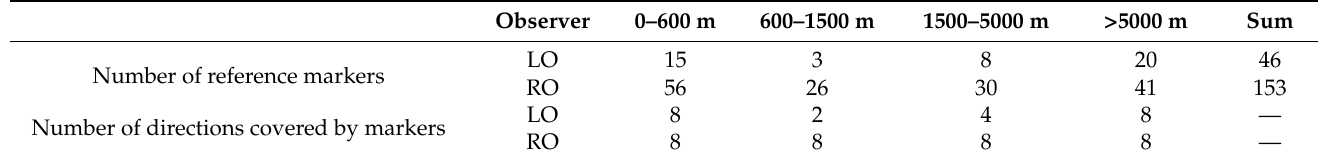
Table 1. The number and the coverage of the reference cardinal directions covered by markers used by local human observers (LO) and the proposed system for remote observation (RO), respectively. Observer 0–600 m